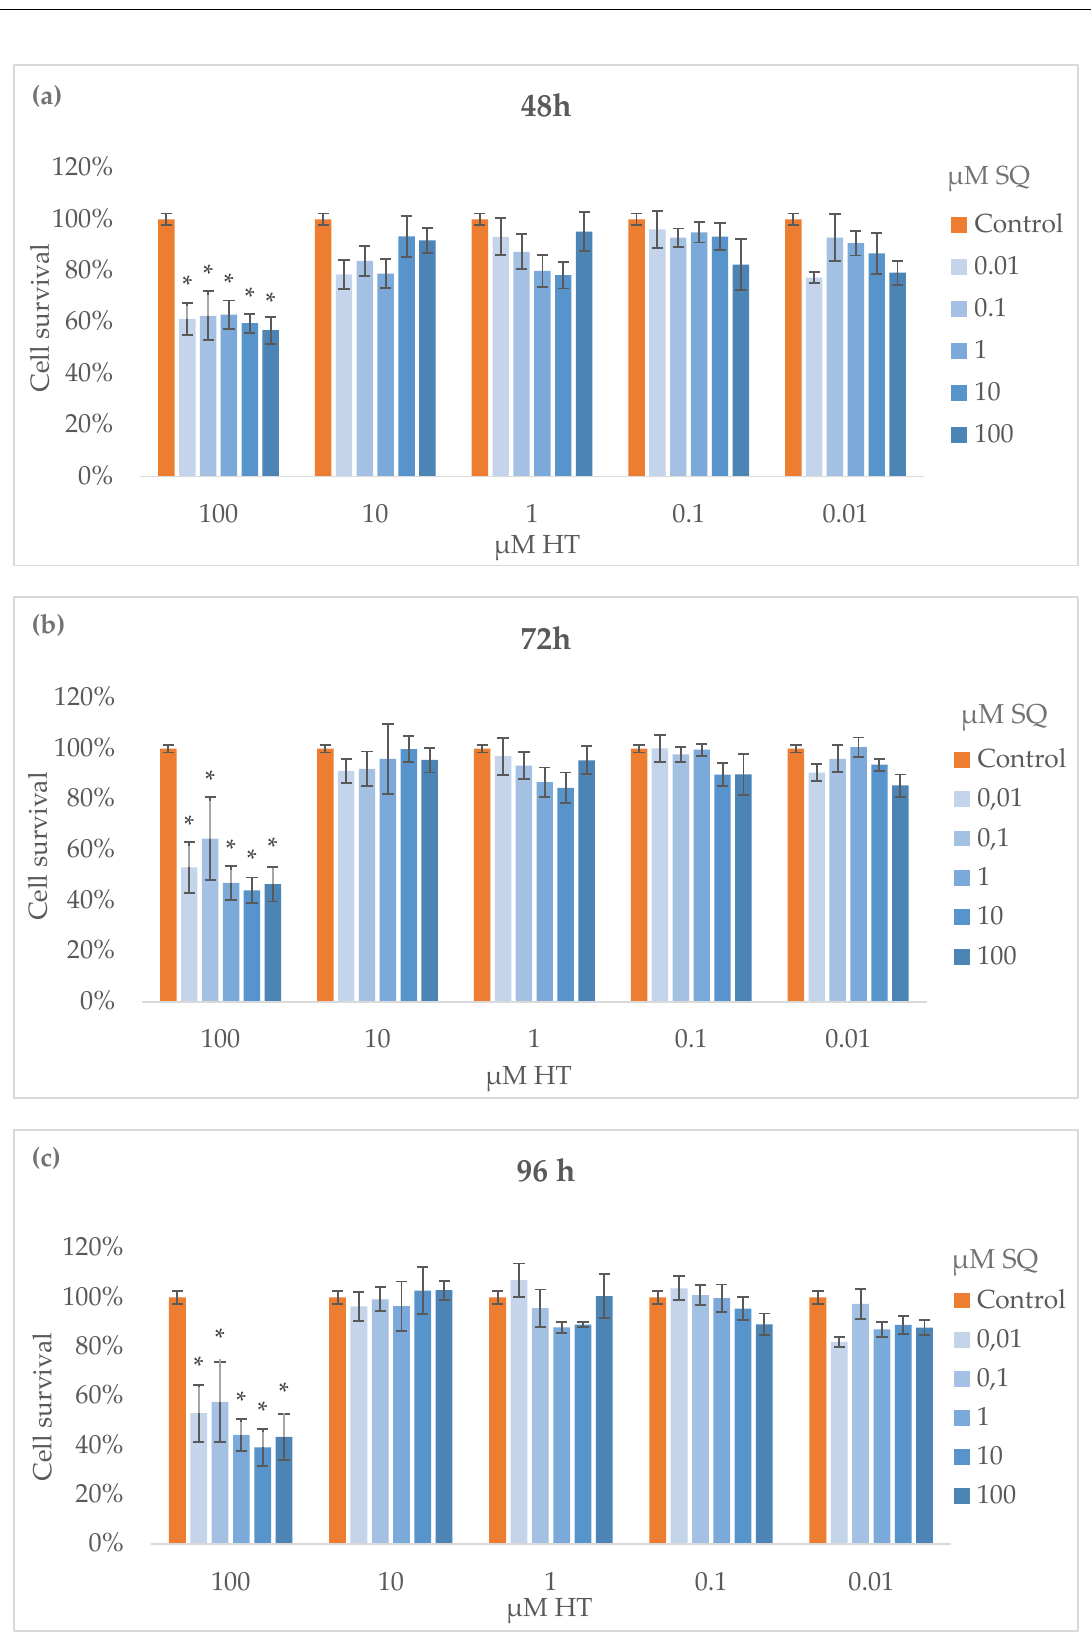
Figure 2. Cell proliferation after 48 h ( a ), 72 h ( b ) and 96 h ( c ) of a combination of HT – SQ from 0.01 μ M to 100 μ M in MDA-MB-231 cells. Data are represented as mean ± SEM of 3 independent experiments (* p < 0.05 compared to untreated control).